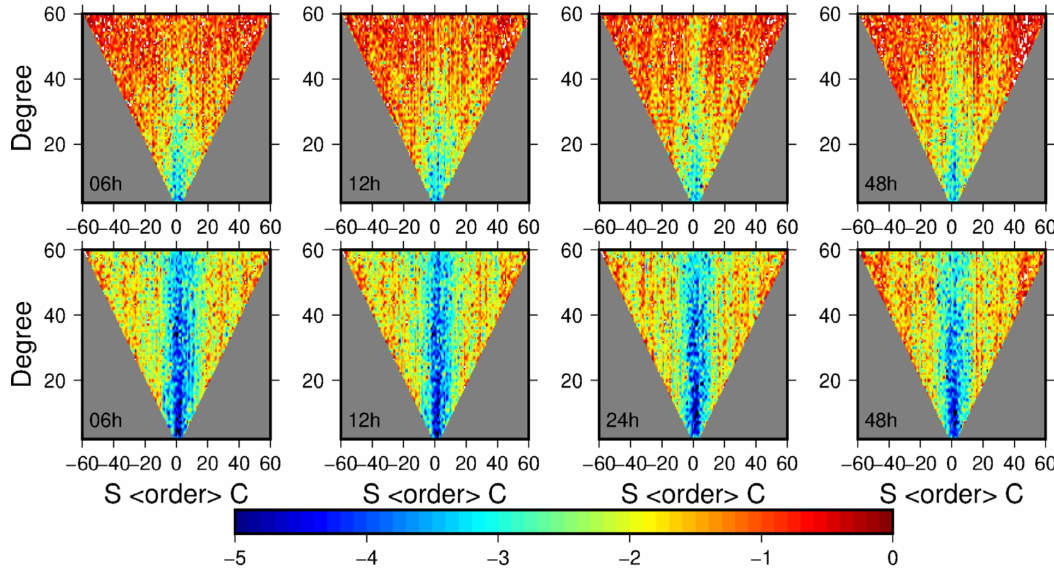
Figure 4. The logarithm of formal errors (comparing the EGM08) in the spherical harmonic coefficients of the recovered gravity field by using 6, 12, 24, and 48 h arcs, when using the range rate data to recover gravity